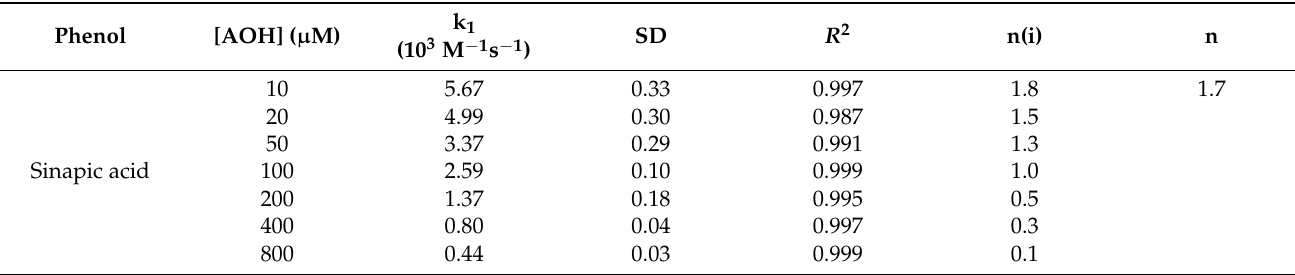
Table 1. Different concentrations of sinapic acid corresponding to different k 1 values. The R 2 value refers to the fitting between experimental values and fitted values. The stoichiometric factor, n, is calculated from the mean of the obtained n(i) of 10 and 20 µ M.